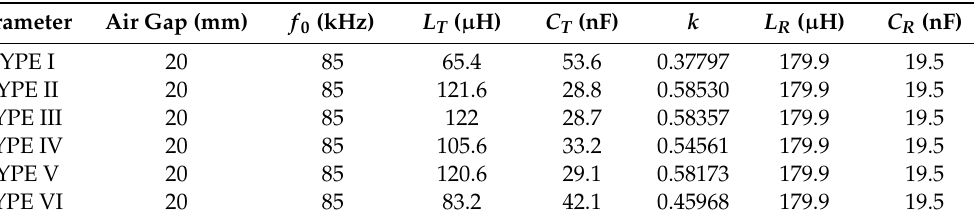
Table 6. Design results of pads according to the ferromagnetic core geometry.